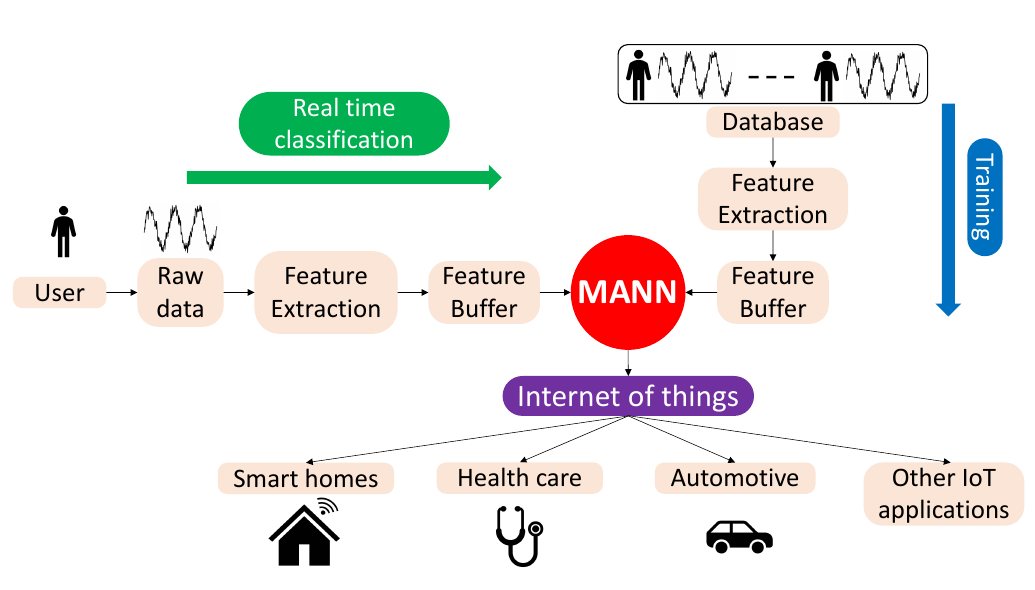
Figure 1. The HAR based on MANN in IoT